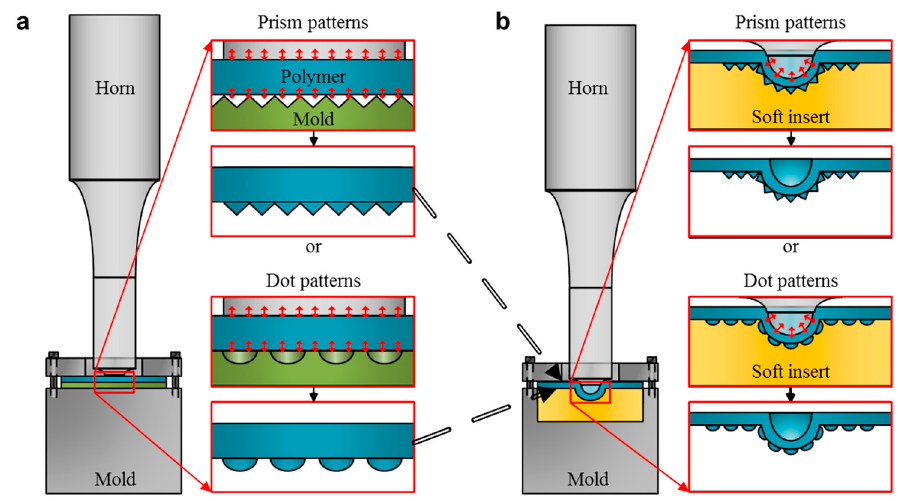
Figure 2. Description of the two-step ultrasonic forming process: ( a ) ultrasonic imprinting; ( b ) ultrasonic stretching.